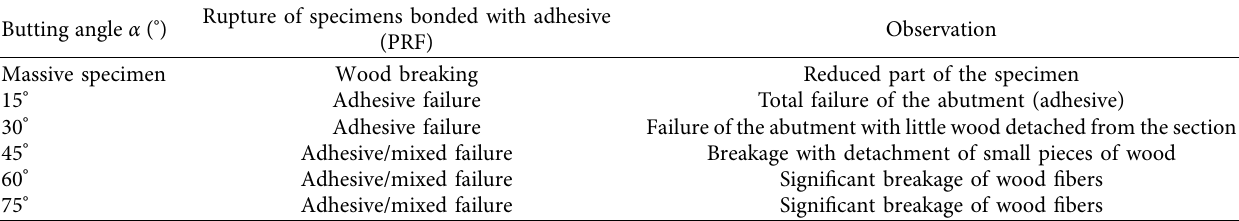
Table 5: Characteristics of the break as a function of the butting angle α